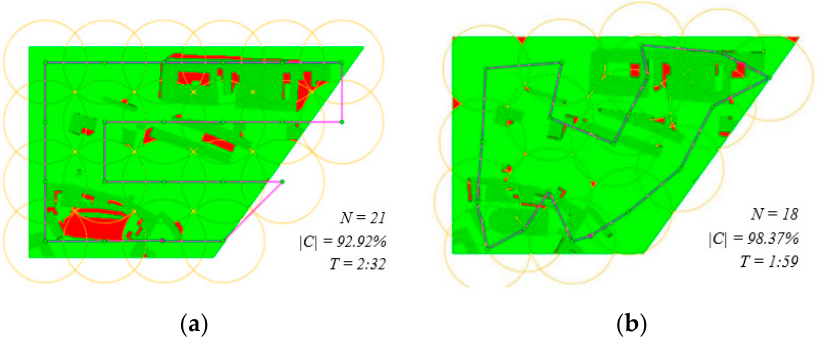
Figure 6. Scenario sc01: ( a ) solution by the zig-zag algorithm; ( b ) solution by the improved CAR model.